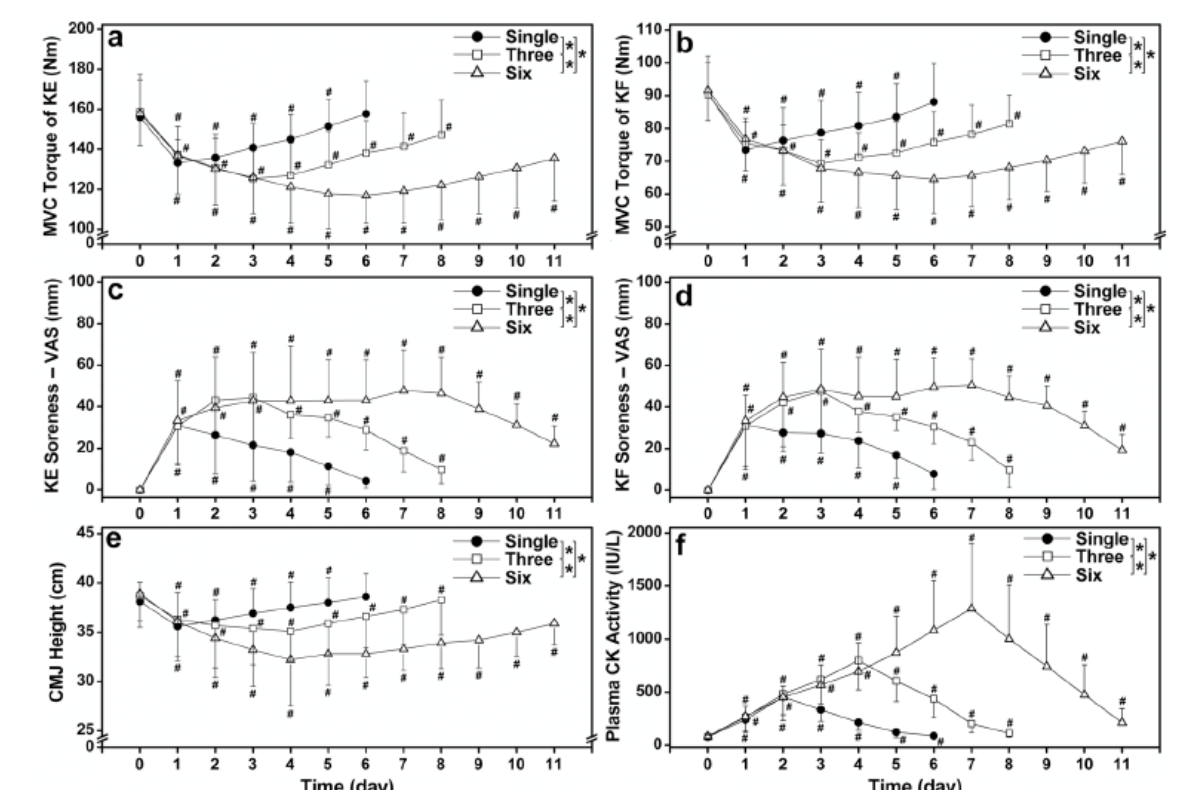
Figure 3. Changes (mean ± SD) in maximal voluntary isometric contraction torque of the knee extensors (MVC-KE, ( a )) and flexors (MVC-KF, ( b )), muscle soreness assessed by a 100-mm visual analog scale of the KE ( c ) and KF ( d ), countermovement jump height (CMJ, ( e )), and plasma creatine kinase (CK) activity ( f ) at baseline (0), 1 h after the Loughborough Intermittent Shuttle Test (LIST) (Day 1), and 1, 2, 3, 4 and 5 d (Day 2–6) after the LIST (Single), before the 1st LIST (0), 1 h after each LIST performed 3 d in a row (Day 1–3) and 1, 2, 3, 4 and 5 d (Day 4–8) after the 3rd LIST (Three), and before the 1st LIST (0), 1 h after each LIST performed 6 d in a row (Day 1–6) and 1, 2, 3, 4 and 5 d (Day 7–11) after the 6th LIST (Six). * indicates a significant ( p < 0.05) difference between groups based on the interaction effect shown by the ANOVA. # indicates a significant ( p < 0.05) difference from the baseline